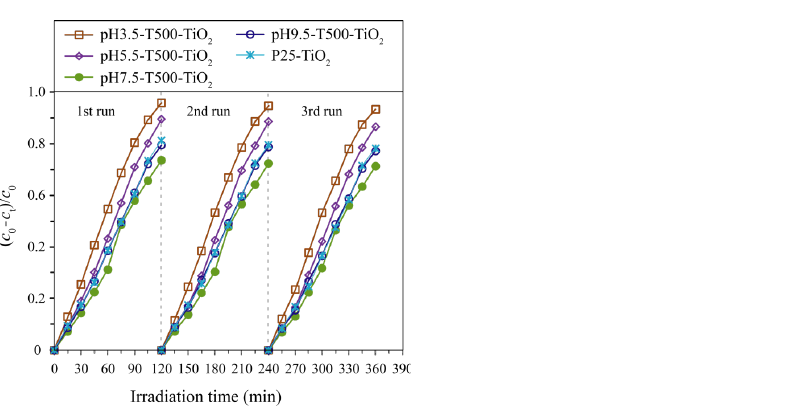
Figure 9. Stability and recyclability performance of pH3.5 − T500 − TiO 2 , pH5.5 − T500 − TiO 2 , pH7.5 − T500 − TiO 2 , pH9.5 − T500 − TiO 2 and pH25 − TiO 2 samples for photocatalytic degradation of methyl orange solution.